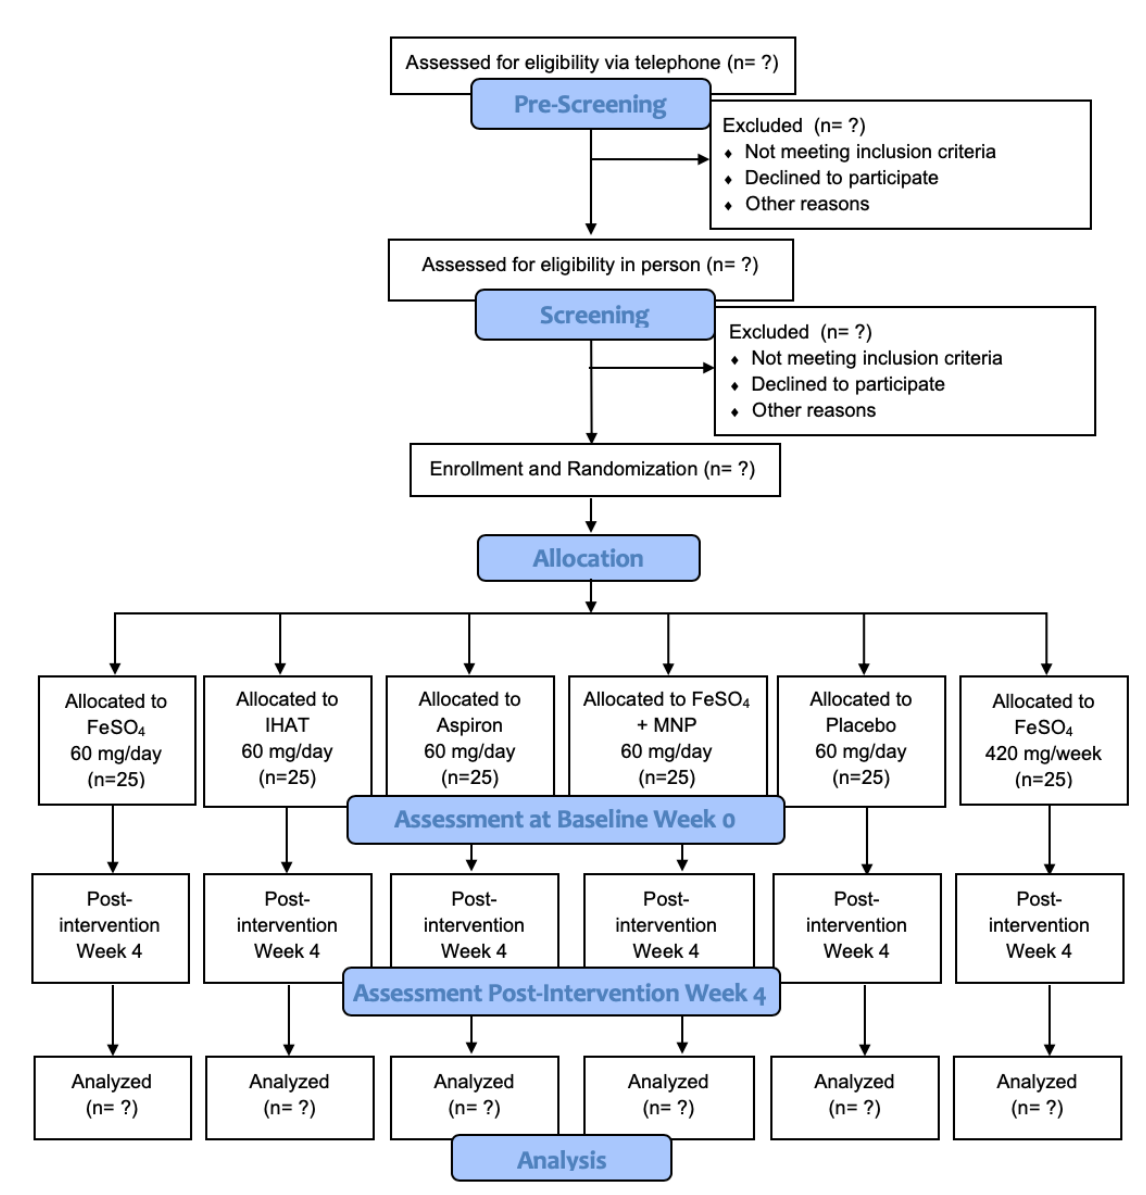
Figure 1. Phase I CONSORT flow